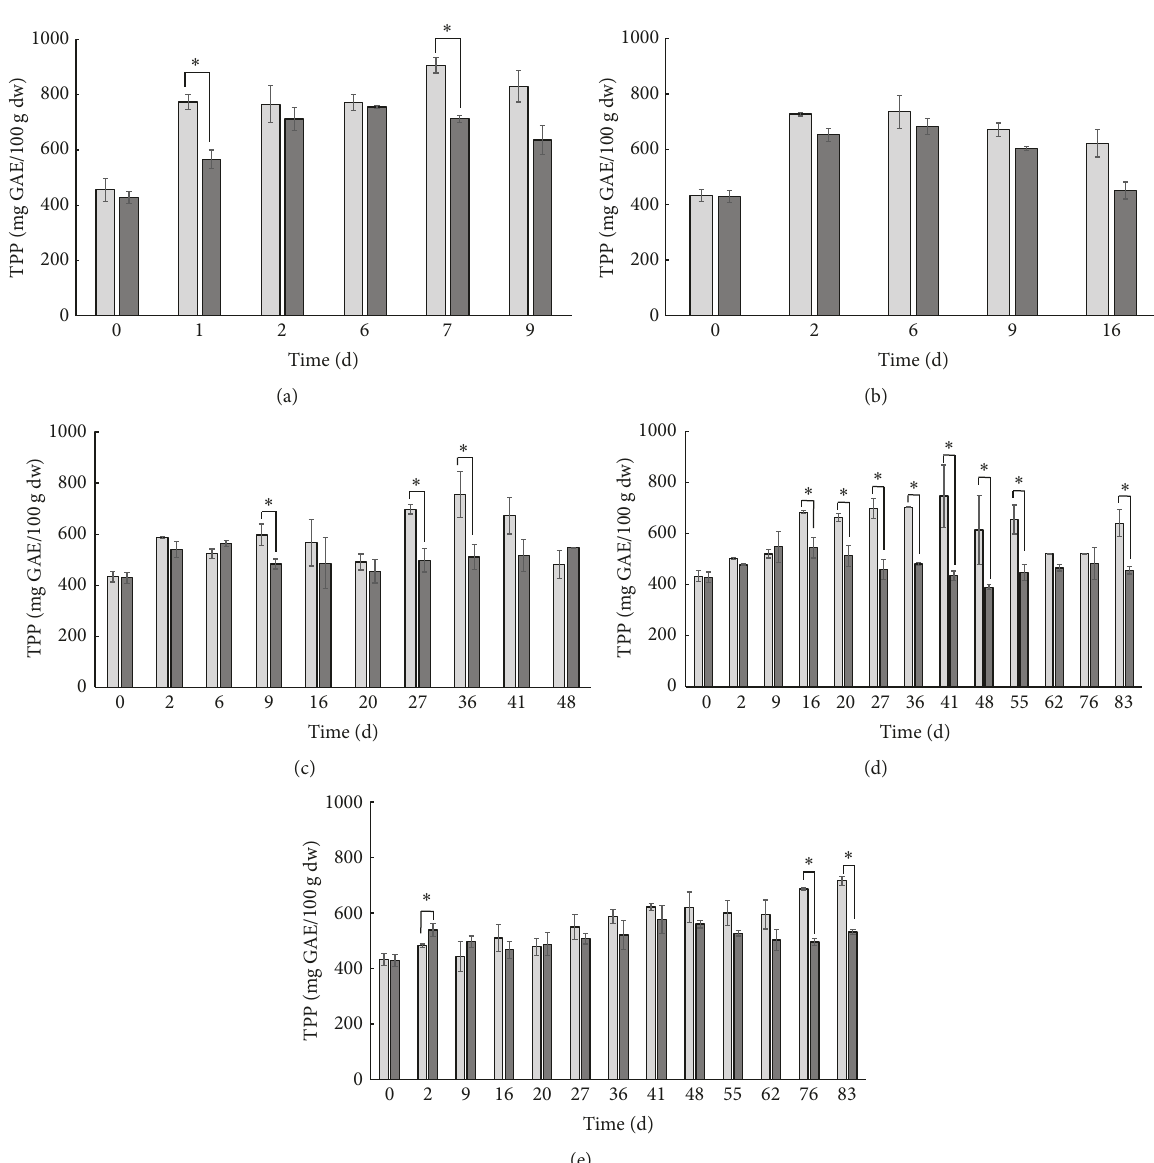
Figure3:Evolutionofthetotalpolyphenols’content(TPP)inblanched(darkbars)andunprocessed(lightbars)broccolifloretsduringstorage at 20 ∘ C (a), 10 ∘ C (b), − 1 ∘ C (c), − 21 ∘ C (d), and − 45 ∘ C (e). Significant differences ( 𝑝 < 0.05 ) between blanched and unprocessed broccoli are highlighted with “ ∗